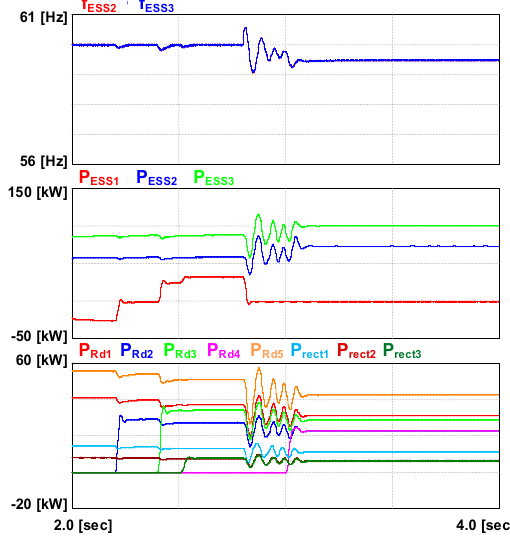
Figure 11. Simulation results—case 3 and case 4.